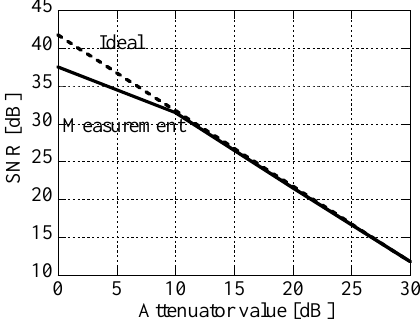
Figure 6. SNR characteristic. Figure 6. SNR